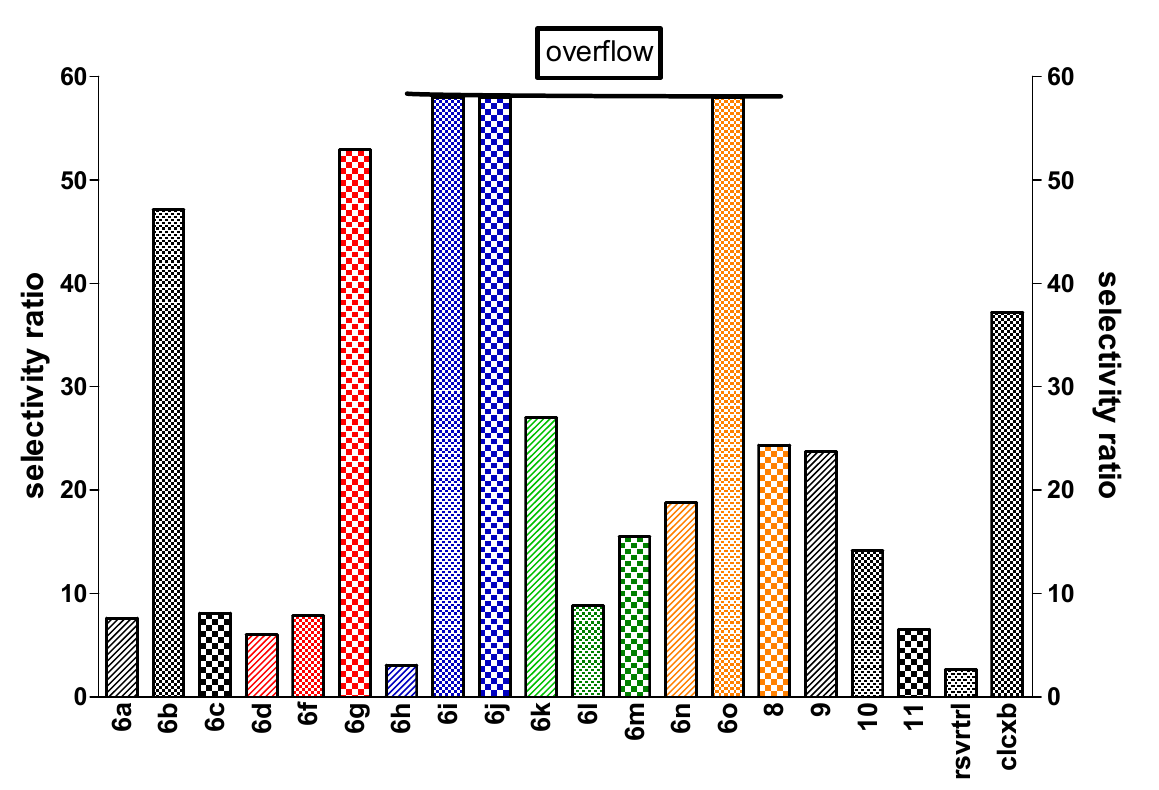
Figure 7. COX-2 vs. COX-1 inhibition ratio by compounds 6i , 6j and 6o were greater than 60 due to their near-background COX-1-inhibition values.